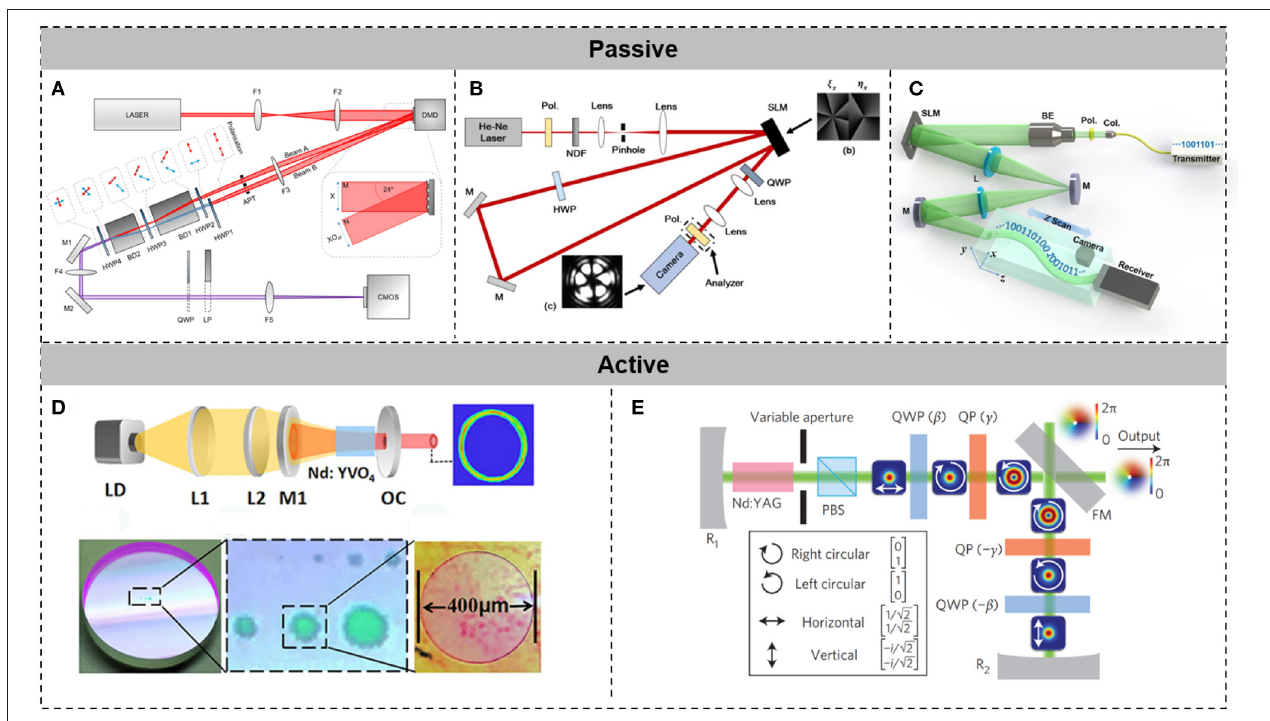
FIGURE 3 | Generation of spatial-structured light beams, utilizing discrete devices. (A) An experimental setup for generating vector beams, using a single DMD. Reprinted from Mitchell et al. [ 36]. (B) An experimental setup for generating vector beams, utilizing a single phase-only SLM. Reprinted from Li and Wang [43]. (C) An experimental setup for generating Airy beams, utilizing a single phase-only SLM. Reprinted from Zhu et al. [3]. (D) A schematic of optical vortex laser, applying a cylindrical lens pair. Reprinted from Qiao et al. [ 38]. (E) A schematic of a vector beam laser, employing a Q plate. Reprinted from Naidoo et al.